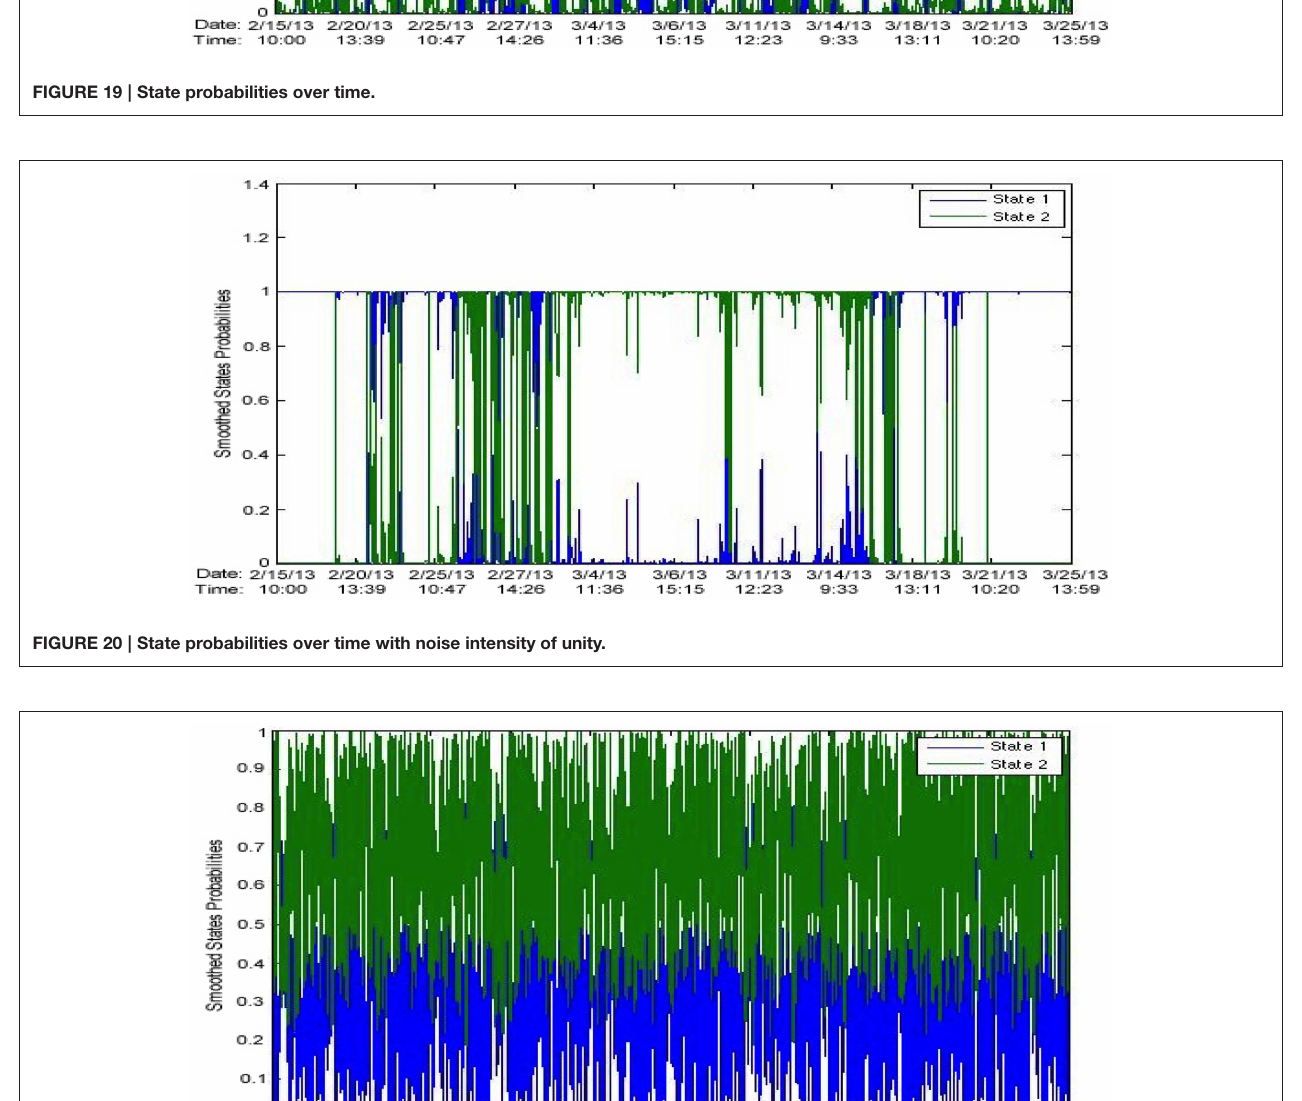
Frontiers in Applied Mathematics and Statistics |